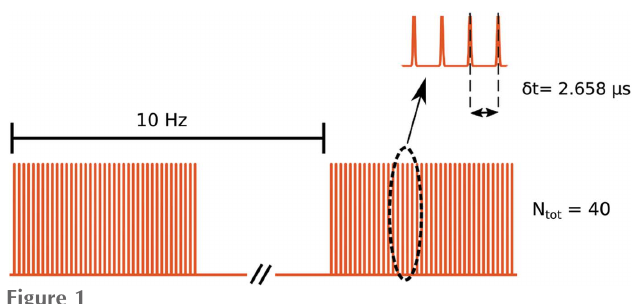
Figure 1 Schematic of a possible pulse scheme. The trains were composed of N tot = 40 pulses separated by (cid:5) t = 2.658 m s; each train is produced with a frequency of 10 Hz. The dashed ellipse highlights a set of pulses reported above on a magnified x -scale. The horizontal axis is not to